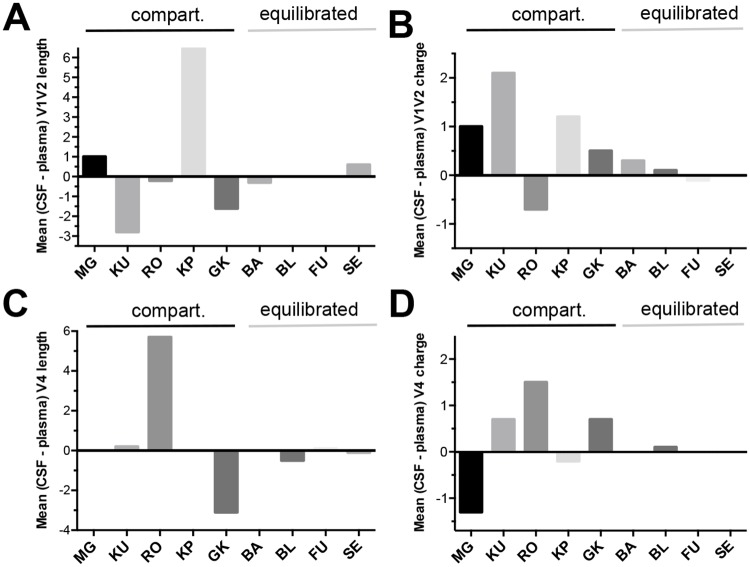
V1V2 and V4 loops length and charge differences of HIV-1 envelope glycoprotein in CSF compartmentalized viral populations.Histograms representing the difference between mean length or charge of V1V2 (A and B respectively) and V4 loops (C and D respectively) of single genome sequences from CSF compared to contemporaneous plasma. Patients are grouped according to evidence of compartmentalization in CSF (* = significant difference between CSF and plasma population by the Mann-Whitney test, p < 0.05).